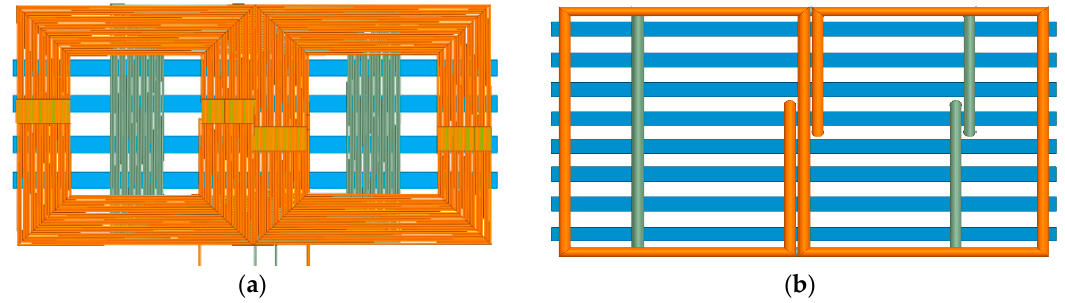
Figure 16. First model of the DDQ pad designed ( a ) and its simplified counterpart used for the simulations ( b ).